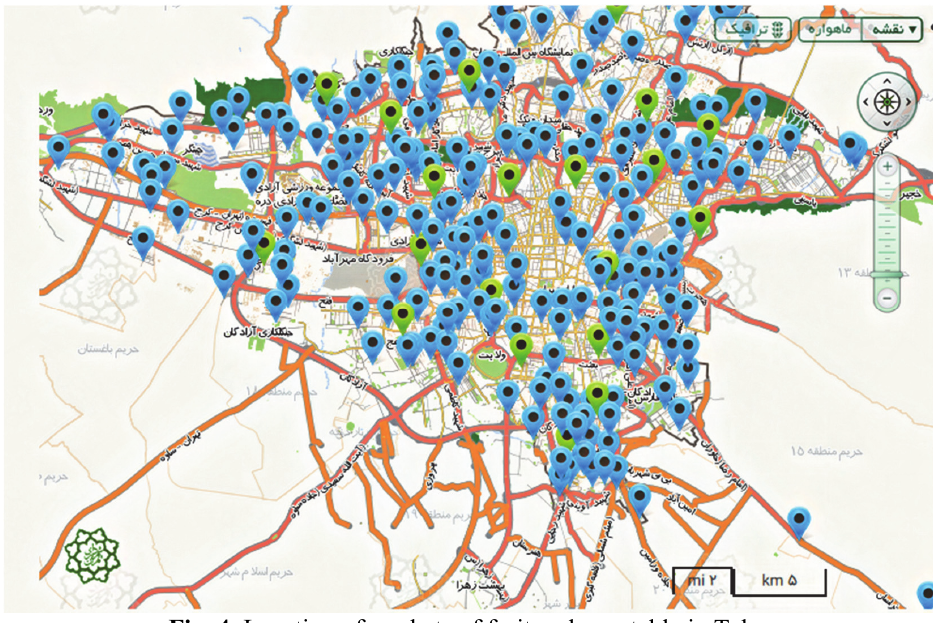
Fig. 4. Location of markets of fruit and vegetable in